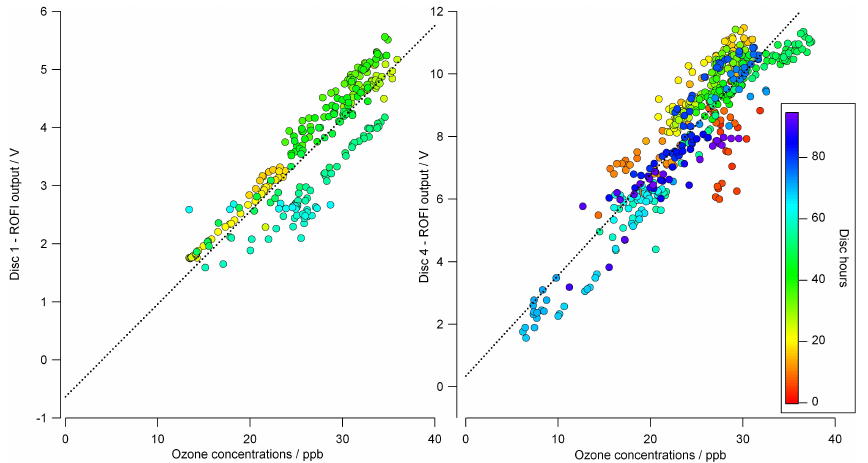
Fig. 3. Offsets in analyser output vary from disc to disc. Negative offset of − 0.65V for disc period 1 (left panel) and positive offset of 0.35V for disc period 4 (right panel). The colour of the symbols is based on the number of h the disc has been exposed to the atmosphere.